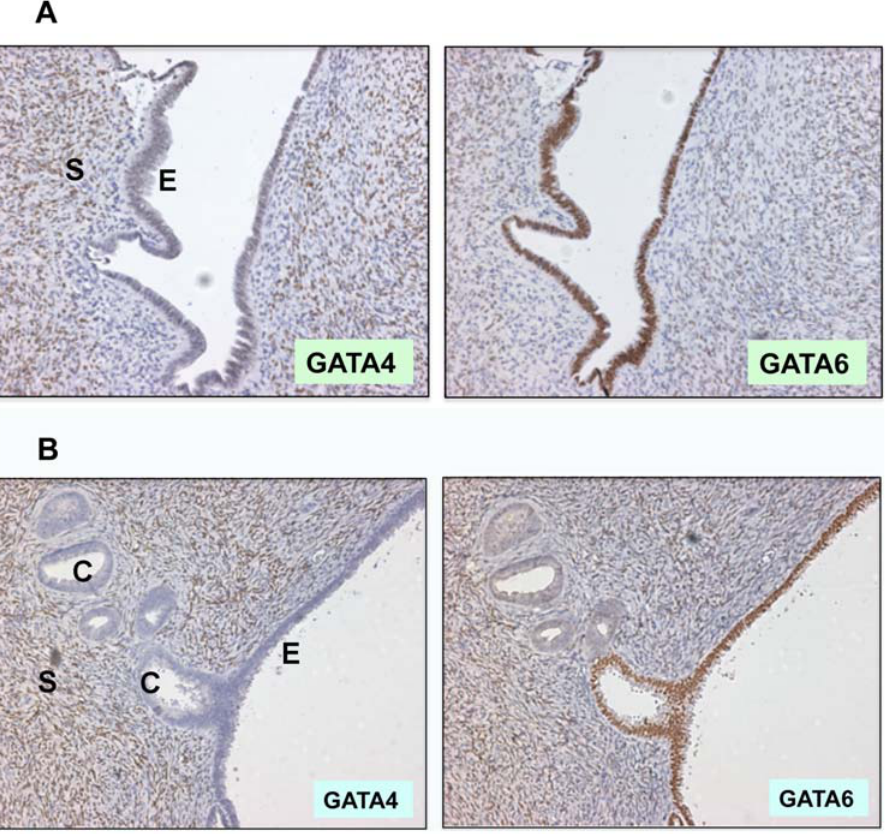
Figure 2. Loss of GATA4 and GATA6 in pre-malignant lesions. Immunostaining of GATA4 and GATA6 in morphologically normal ovarian surface and/or cyst epithelia found in ovarian carcinomas. A . An ovarian surface epithelium is positive for GATA6 and negative for GATA4. Positive GATA4 staining in stroma is noted. B . An ovarian surface epithelium is positive for GATA6 and negative for GATA4. Both GATA4 and GATA6 are lost in cyst epithelial cells adjacent to the surface. 200 6 magnification. E , epithelium; C , cyst; S , stroma.